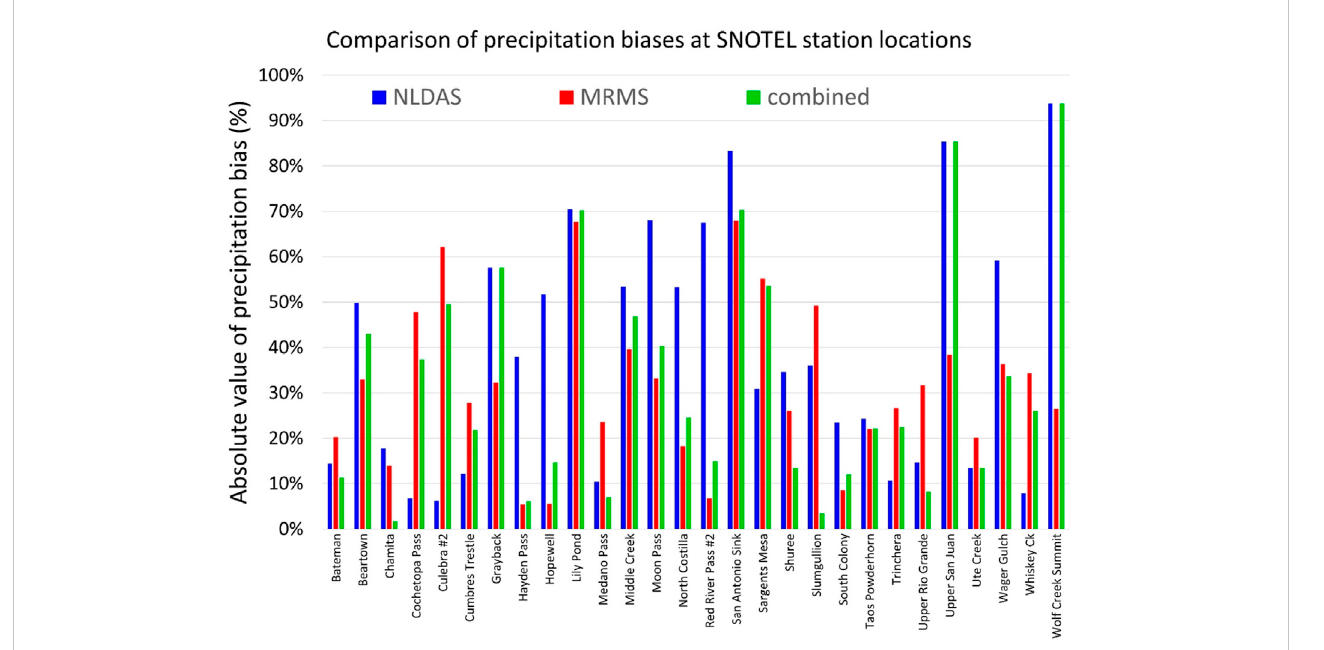
FIGURE 9 The absolute value of precipitation percentage biases at each SNOTEL station location.